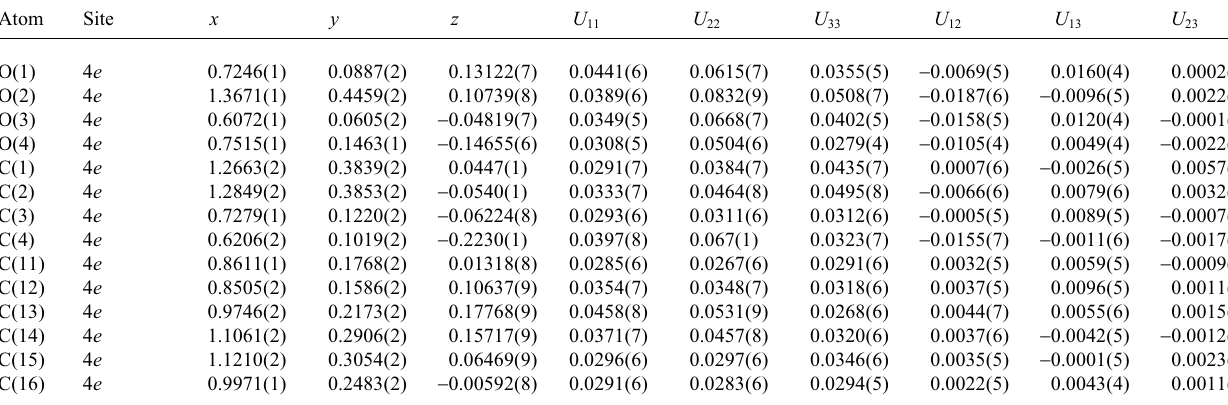
Table 3. Atomic coordinates and displacement parameters (in Å 2 )